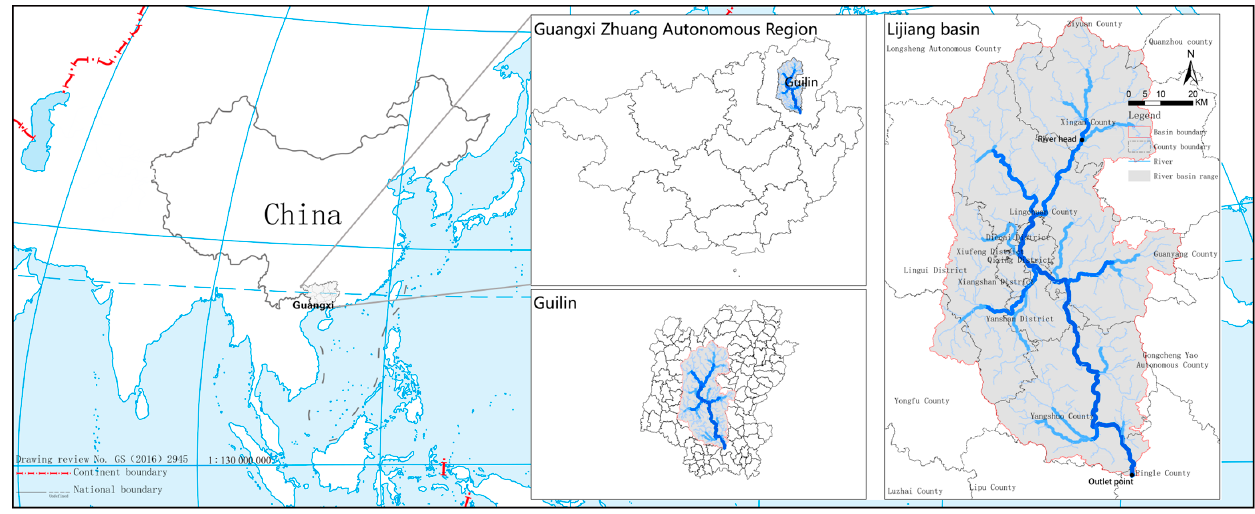
Figure 1. Location of the Lijiang River